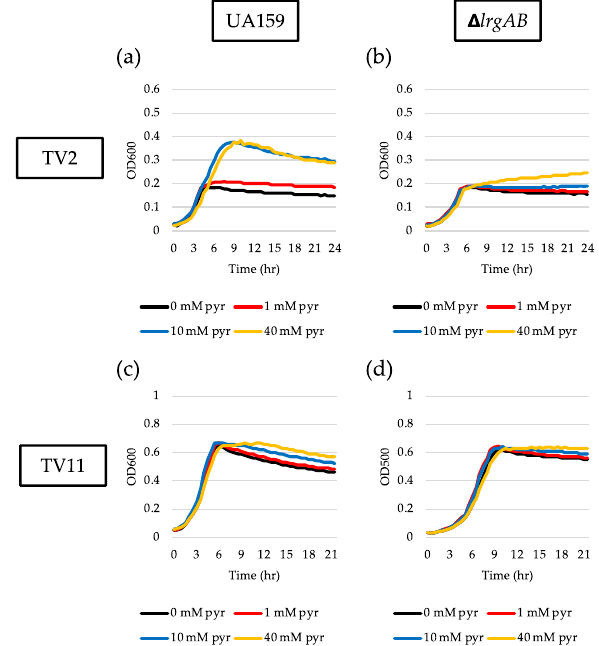
Figure 5. The e ff ect of exogenously added pyruvate on the stationary phase of S. mutans UA159 wild type and ∆ lrgAB mutant strains, grown in TV2 and TV11 media. Wild type ( a and c ) and ∆ lrgAB ( b and d ) strains were grown in TV2 ( a and b ) and TV11 ( c and d ), supplemented by di ff erent concentrations of pyruvate (0, 1, 10 and 40 mM). Optical density at 600 nm was monitored every 30 min at 37 ◦ C using the Bioscreen C lab system. The results are representative of three independent experiments.